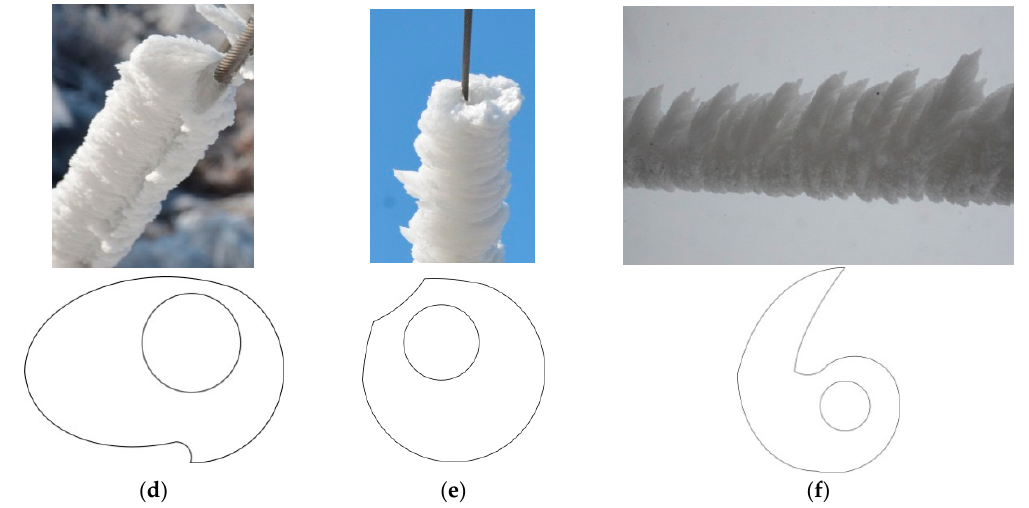
Figure 2. Typical ice profiles of the iced conductors ( a ) Crescent shape; ( b ) Wing shape; ( c ) Wing shape and eccentric circle; ( d ) Eccentric oval shape; ( e ) eccentric round shape; ( f ) Wing shape and round shape.